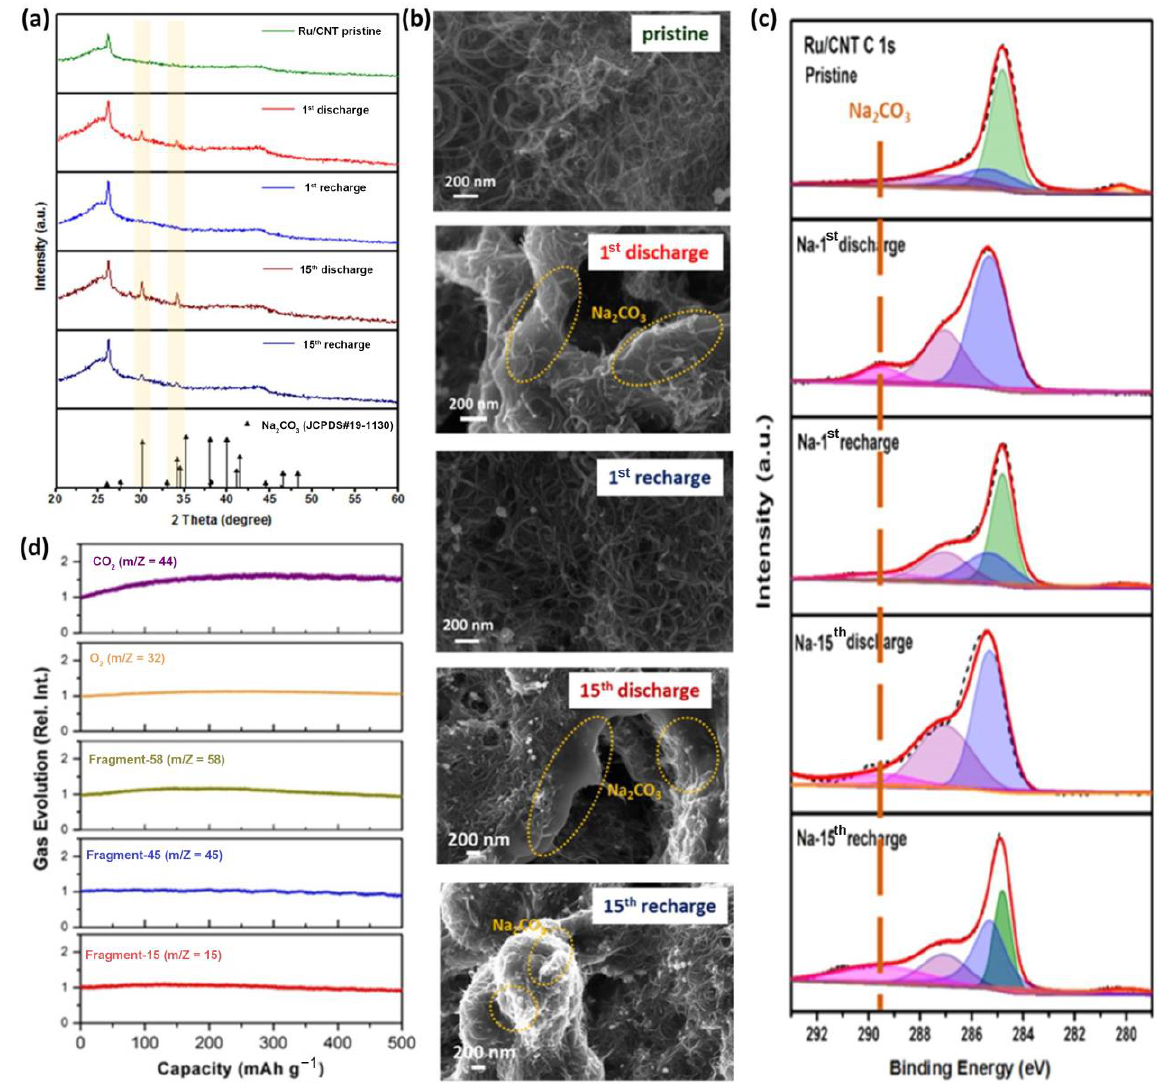
Figure 5. ( a ) XRD patterns, ( b ) SEM images, and ( c ) XPS spectra of Ru/CNT electrodes of the 1st and the 15th discharge − charge cycles in Na−CO 2 batteries; ( d ) In situ GC−MS characterization to detect gas evolution during the charging of Na-CO 2 batteries with the Ru/CNT cathode. Reproduced with permission from [80]. Copyright 2021, American Chemical Society.